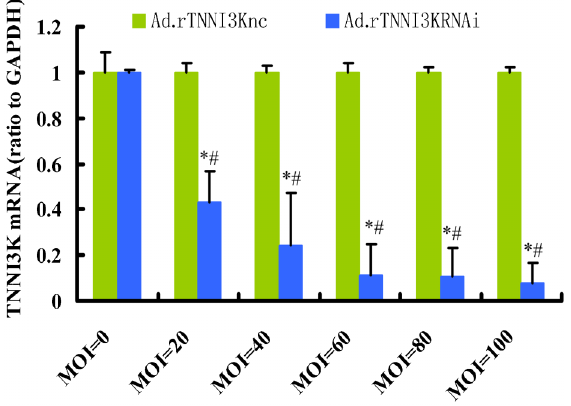
Figure 4. Knockdown of human cardiac troponin I-interacting kinase (TNNI3K) in isolated rat adult cardiomyocytes. Freshly isolated rat adult cardiomyocytes were infected with an adeno- virus carrying shRNA for silencing TNNI3K or scrambling shRNA for 24 h at the indicated multiplicity of infection (MOI). Samples were analyzed by quantitative real-time reverse transcription polymerase chain reaction and normalized to glyceraldehyde-3- phosphate dehydrogenase (GAPDH). Data are reported as means ± SE (n = 6). *P , 0.01 vs control (MOI = 0); # P , 0.01 vs green bar at the same MOI value (one-way ANOVA).